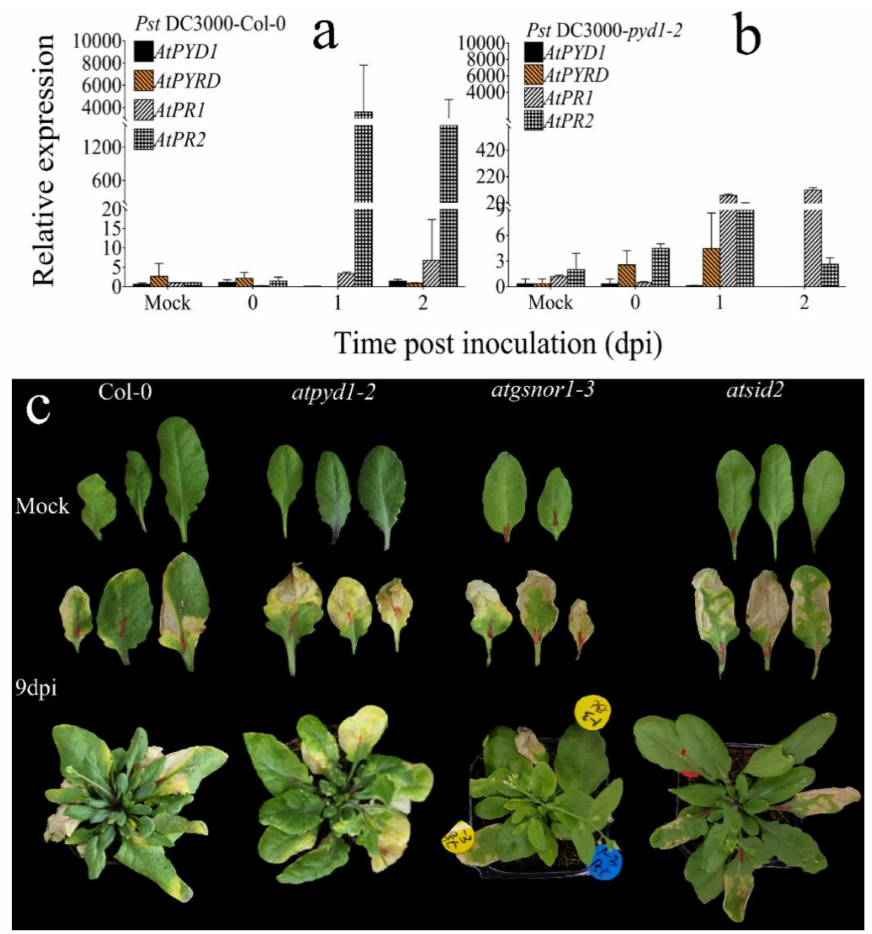
Figure 3. Transcriptional response of AtPYD1 under bacterial Pst DC3000 vir infection. ( a ) Transcriptional response of the Arabidopsis PYD1 , PYRD, PR1 and PR2 under Pst DC3000 vir infection over time, ( b ) expression patterns of same genes listed in the loss of function mutant atpyd1-2 background, and ( c ) phenotype of Arabidopsis atpyd1-2 loss of function mutant towards Pst DC3000 vir infection. The phenotype was recorded at 9